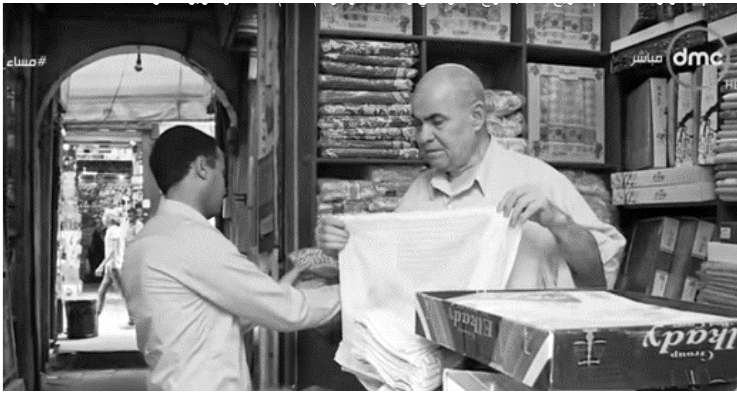
Figure 13. Interior of a shop, on the ground floor of Wikāliẗ ạl - ’Anbariyin, overlooks ạl-Muʿiz Street. (Source: DMC video, 2018.